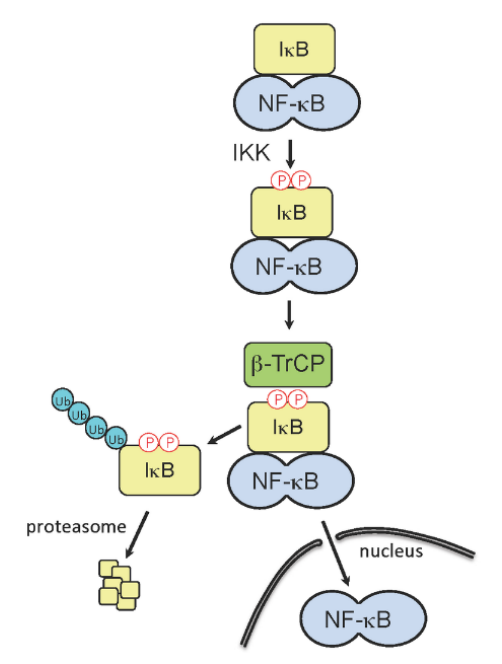
FIGURE 1: Activation of NF-κB. Upon detection of RNA-virus infection by the host cell, signaling cascades are induced which can trigger IFN expression and the establishment of an antiviral state. The inducible IκB kinase (IKK) plays critical role in IFN signaling cas- cades, as its activity is responsible for phosphorylation of the IκB degron. The phosphorylated IκB degron is recognized by β-TrCP, a substrate-specific adaptor of an E3 ubiquitin ligase complex, SCF βTrCP , leading to IκB ubiquitination and degradation. IκB degradation releases NF-κB, allowing the transcription factor to translocate to the nucleus and upregulate IFN